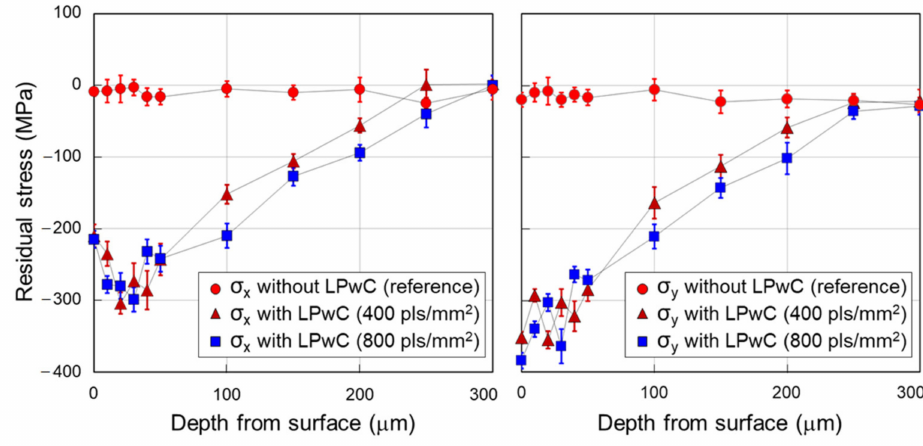
Figure 6. RS depth profiles of A7075-T73 in the X-direction ( left ) and Y-direction ( right